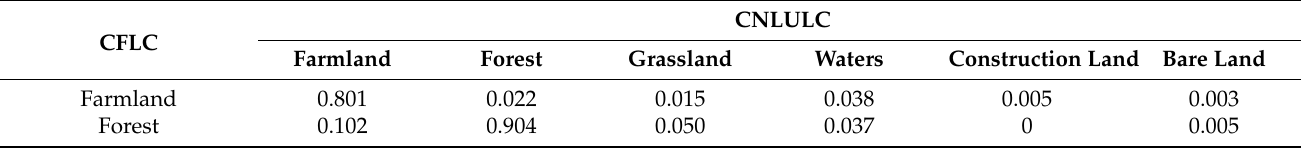
Table 3. The error matrix of the CFLC and CNLULC under a 6-class system.